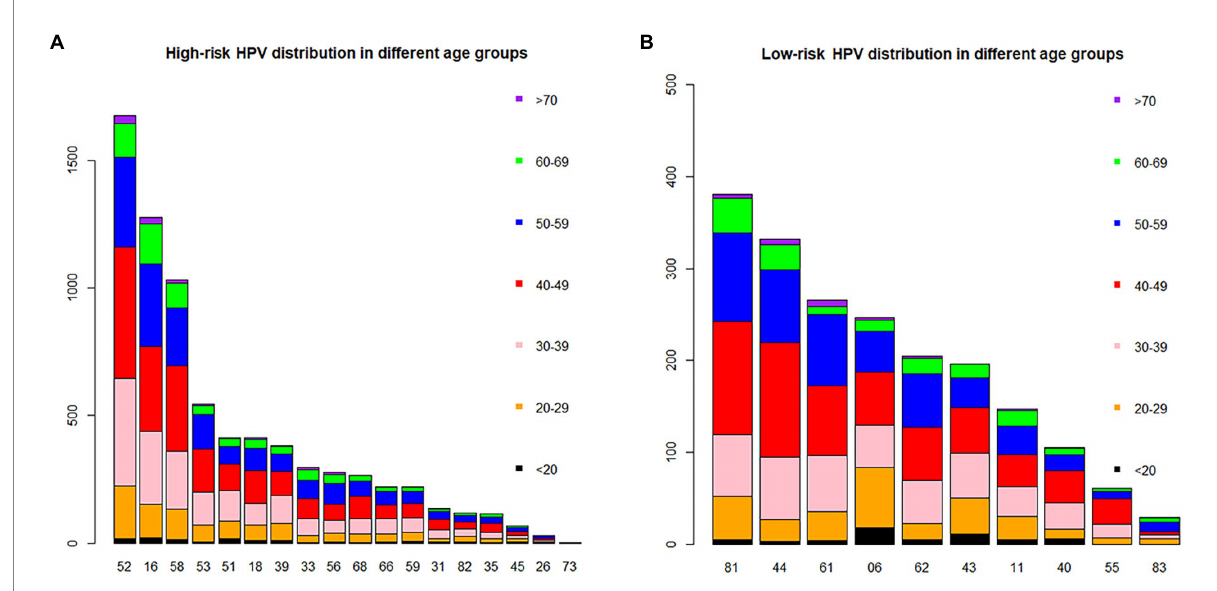
FIGURE 2 The distribution of HPV genotypes in different age groups. Each bar represents the number of infections due to corresponding HPV genotypes. Black, yellow, pink, red, blue, green and violet indicate the numbers of infections in the <20, 20–29, 30–39, 40–49, 50–59, 60–69 and >70 years groups for the corresponding genotypes, respectively. (A) High-risk HPV infection. (B) Low-risk HPV infection.